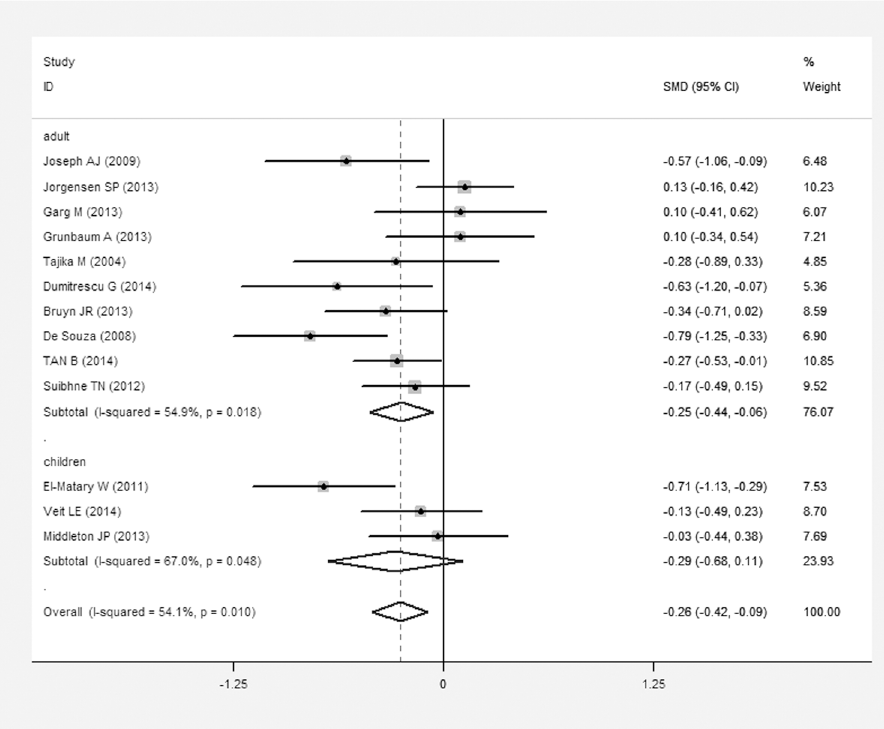
Fig 2. Meta-analysis of studies reporting 25(OH)D levels in CD patients vs. controls, a standardized mean difference with a 95% confidence interval and weight percentage. Subtotals of adults and children, and overall